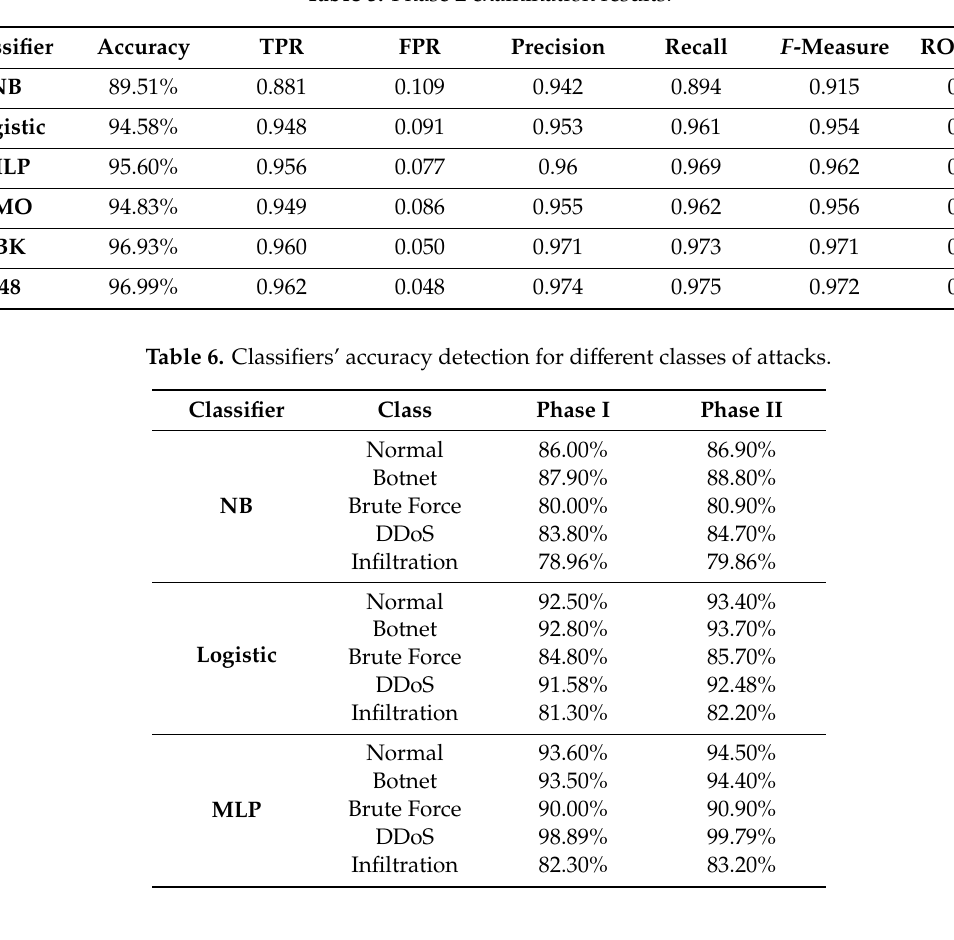
Table 5. Phase 2 examination results.